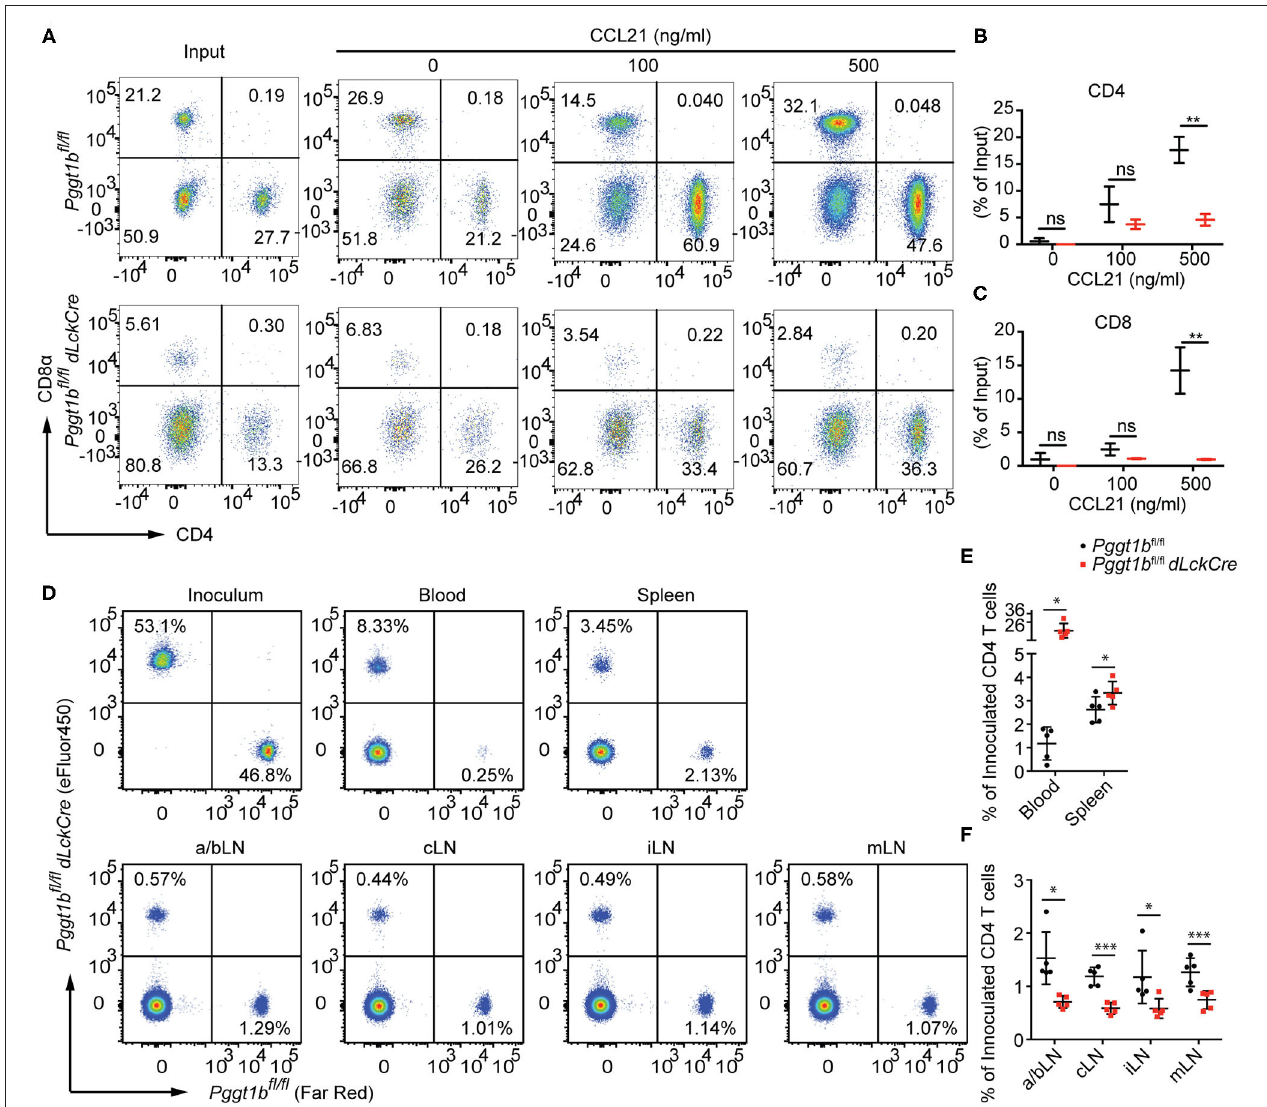
FIGURE 3 | Defective in vitro transmigration and in vivo homing of Pggt1b-deficient CD4 + T cells. (A) Flow cytometry analysis of CD4 + , CD8 + T cells in transwell migration assay in response to CCL21; (B,C) percentage of input CD4 + (B) and CD8 + (C) cells migrated into the low chamber of transwell in response to CCL21; (D) Flow cytometry analysis of eFluor450-labelled CD4 + naive T cells from Pggt1b fl / fl mice or Far Red-labelled naive CD4 + T cells from Pggt1b fl / fl dLckCre mice that were mixed at a ratio of 1:1 before injected i.v. into recipient mice; (E,F) Percentage of CD4 + T cells out of the total cells injected in the blood, spleen (E) and various lymph nodes (F) of the recipient mice. Each dot represents a single mouse. a/b, axillary and brachial; c, cervical; i, inguinal; m, mesenteric lymph nodes (n.s. statistically not significant; * p < 0.05, ** p < 0.01, *** p < 0. 001, unpaired t